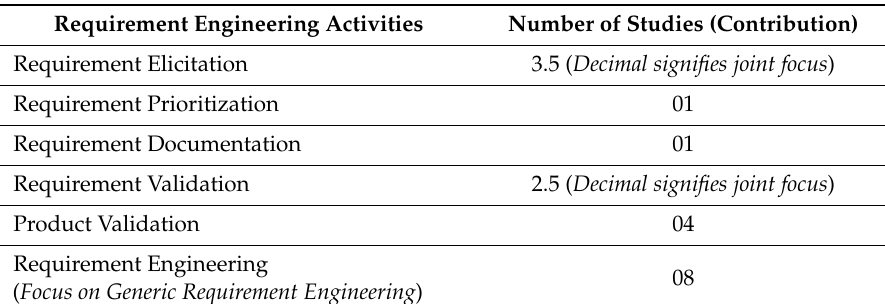
Table 5. Research Focus on Requirement Engineering Activities.